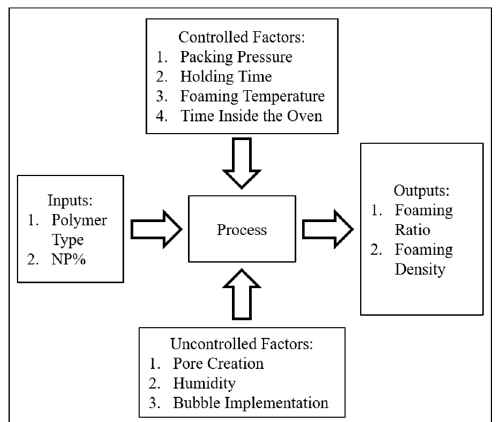
Figure 2. Process model used to produce polymer foam.